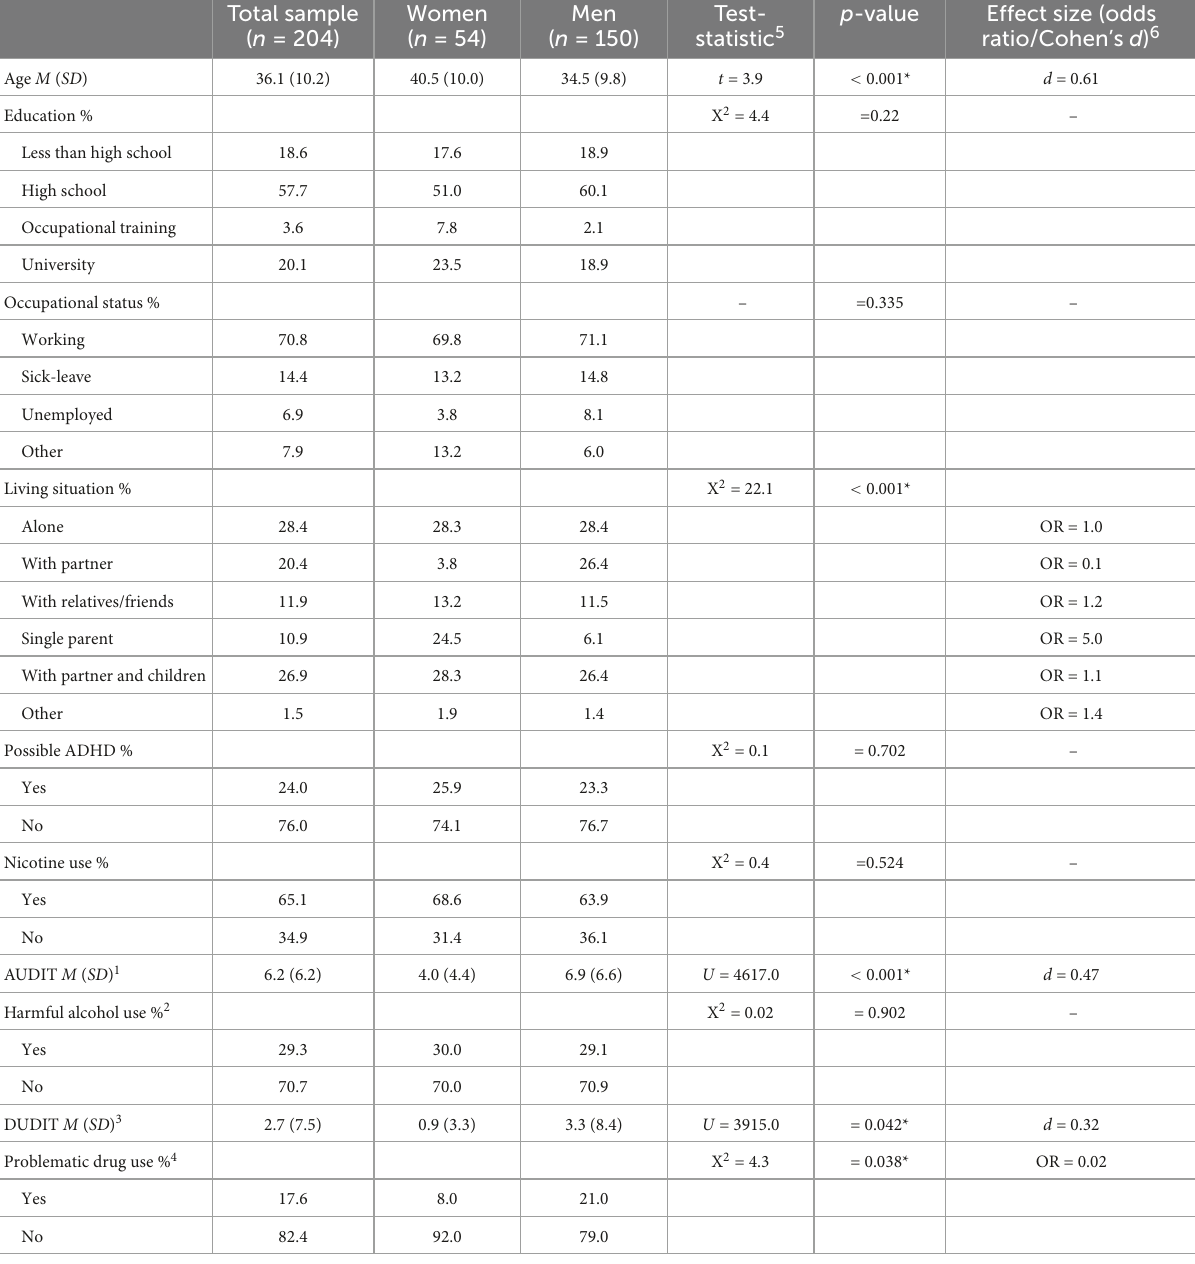
TABLE 1 Demographics of total sample, women, and